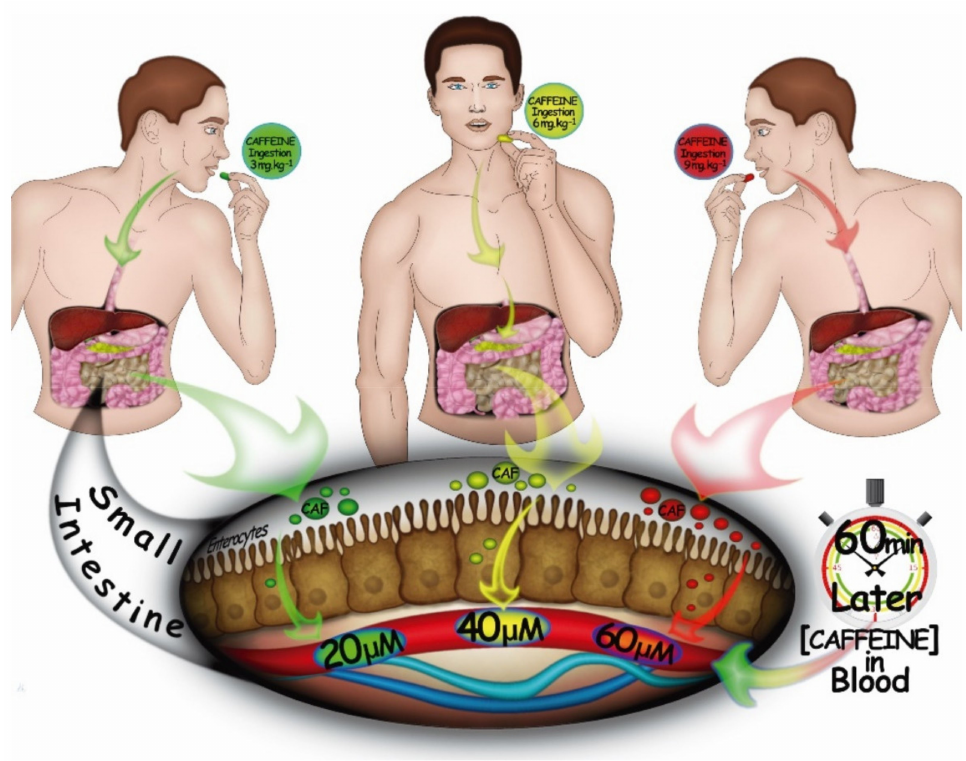
Figure 1. An illustration of the caffeine absorption process. Following doses of 3 to 9 mg kg − 1 of body mass, caffeine is completely absorbed by the gastrointestinal tract and peaks in the plasma in a dose-dependent manner within approximately 60 min after ingestion [4].